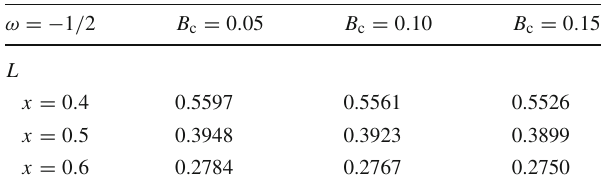
Table 2 The latent heat of the phase transition for different B c with ω = − 1 /